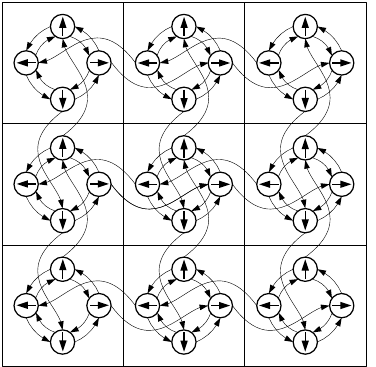
Figure 2. The graph captures the allowed movements of the robot on a grid map when Θ = { 0 , π , π, 3 π } and only forward movements are allowed. Small circles indicate the 2 2 poses where the robot can stop (the internal arrow indicates the orientation of the robot) and the directed edges its allowed movements. Note that in the figure the poses do not correspond to the centers of the cells, but this is only for clarity